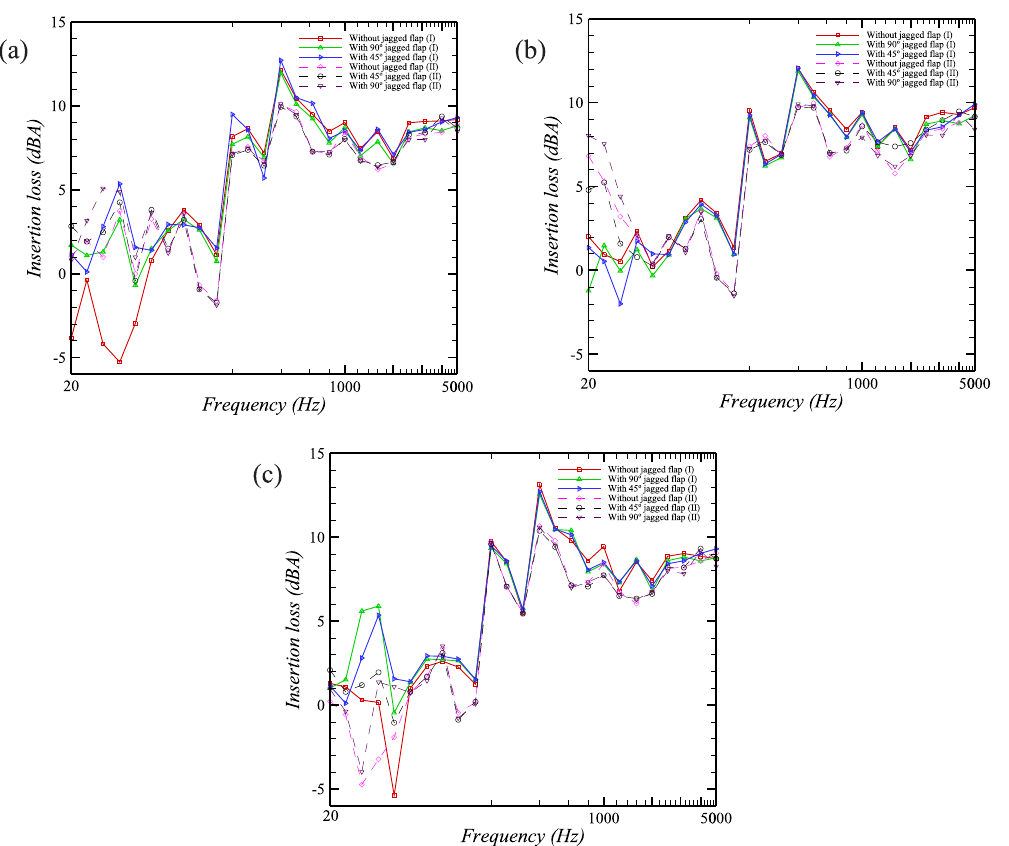
Figure A2. IL 1 gained by the plenum window with perforated thin box (compared with the case of without window) for experiments I and II. ( a ) White noise ( b ) traffic noise ( c ) construction noise. Results are presented using one third octave frequency band in log